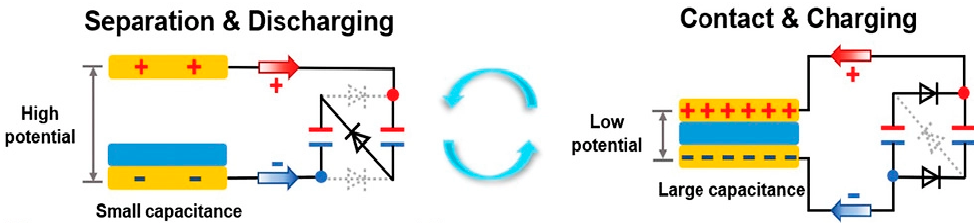
Figure 13. Working mechanism of self-charge excitation TENG during the periodic contact-separation process [52].